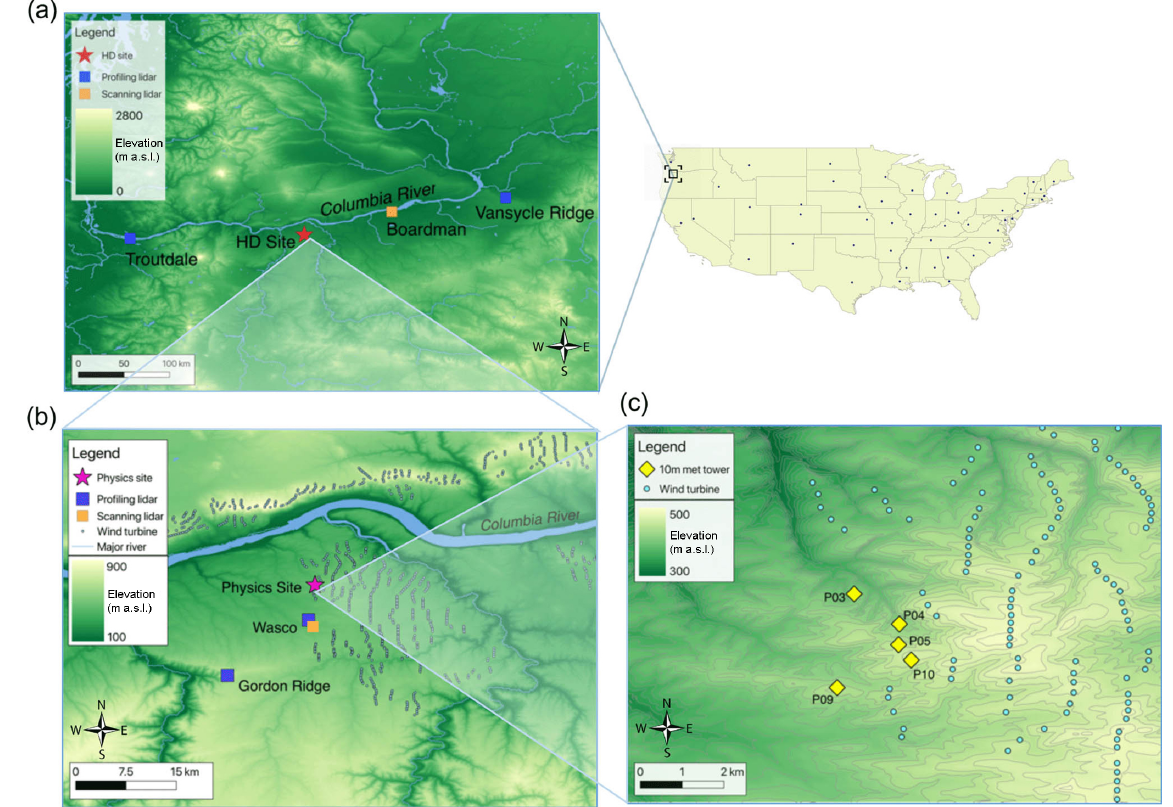
Figure 1. Map of the relevant instruments during the WFIP2 field campaign. The locations of the profiling lidars, scanning lidars, and meteorological towers used in this analysis are shown. (c) Elevation contour lines are shown every